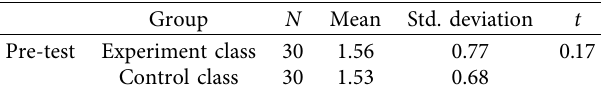
Figure 4: Percentages of metacognitive skill indicators on conjecturing process. Table 3: Independent-samples t -test (post-test of control class and Table 2: Independent-samples t -test (pre-test of control class and experimental experimental class).